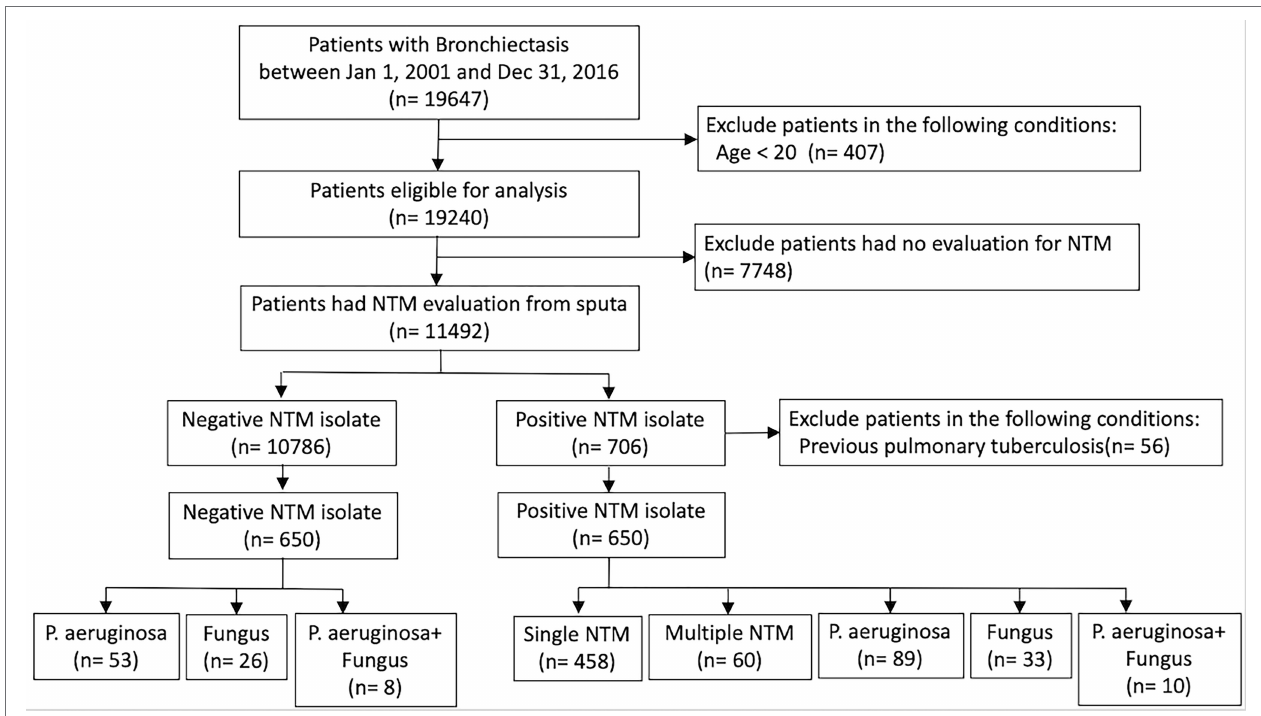
FIGURE 1 | Flowchart of the study design. NTM, nontuberculous